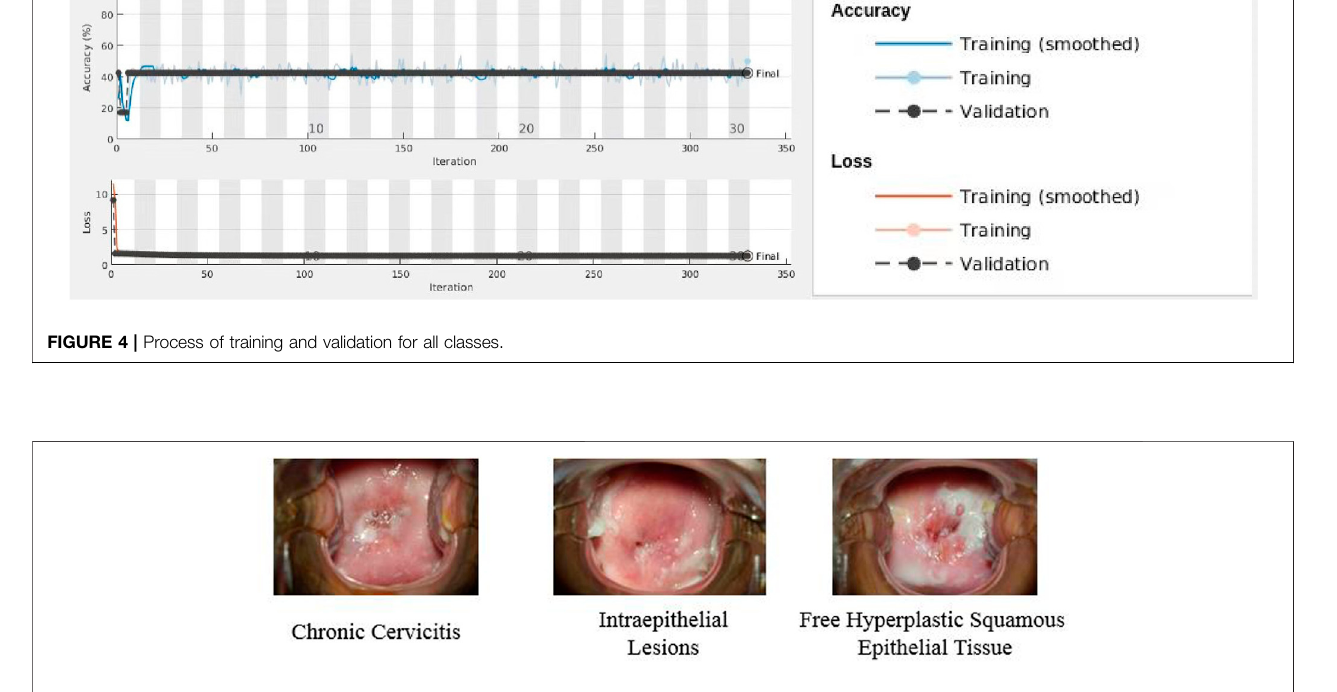
FIGURE 5 | Examples of similar images of different features.